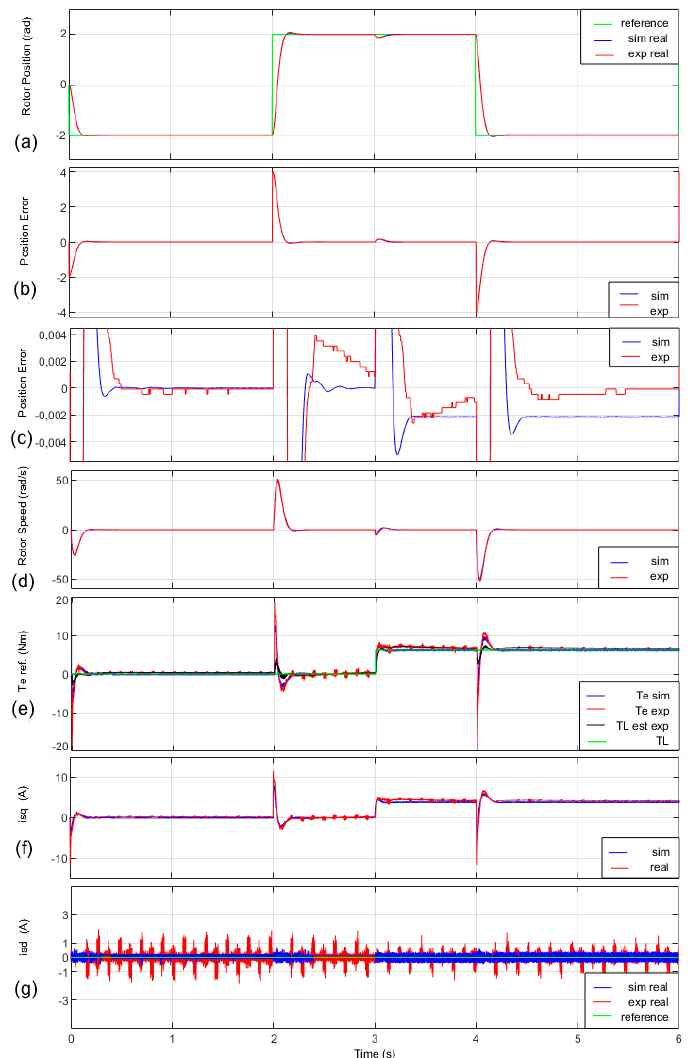
Figure 9. Simulation and experimental tests’ performances employing the D1 design for the PMSM machine: ( a ) rotor position, reference and real (rad); ( b ) rotor position error (rad); ( c ) rotor position error zoom (rad); ( d ) rotor speed (rad/s); ( e ) electromagnetic torque (Te), estimated load torque (TL est) and load torque (TL), (N·m); ( f ) torque current, isq (A); ( g ) rotor flux current, reference and real, isd (A).